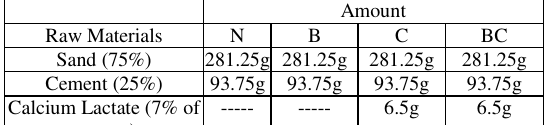
Table 3: Amount of Raw Material for Different Types of Cement